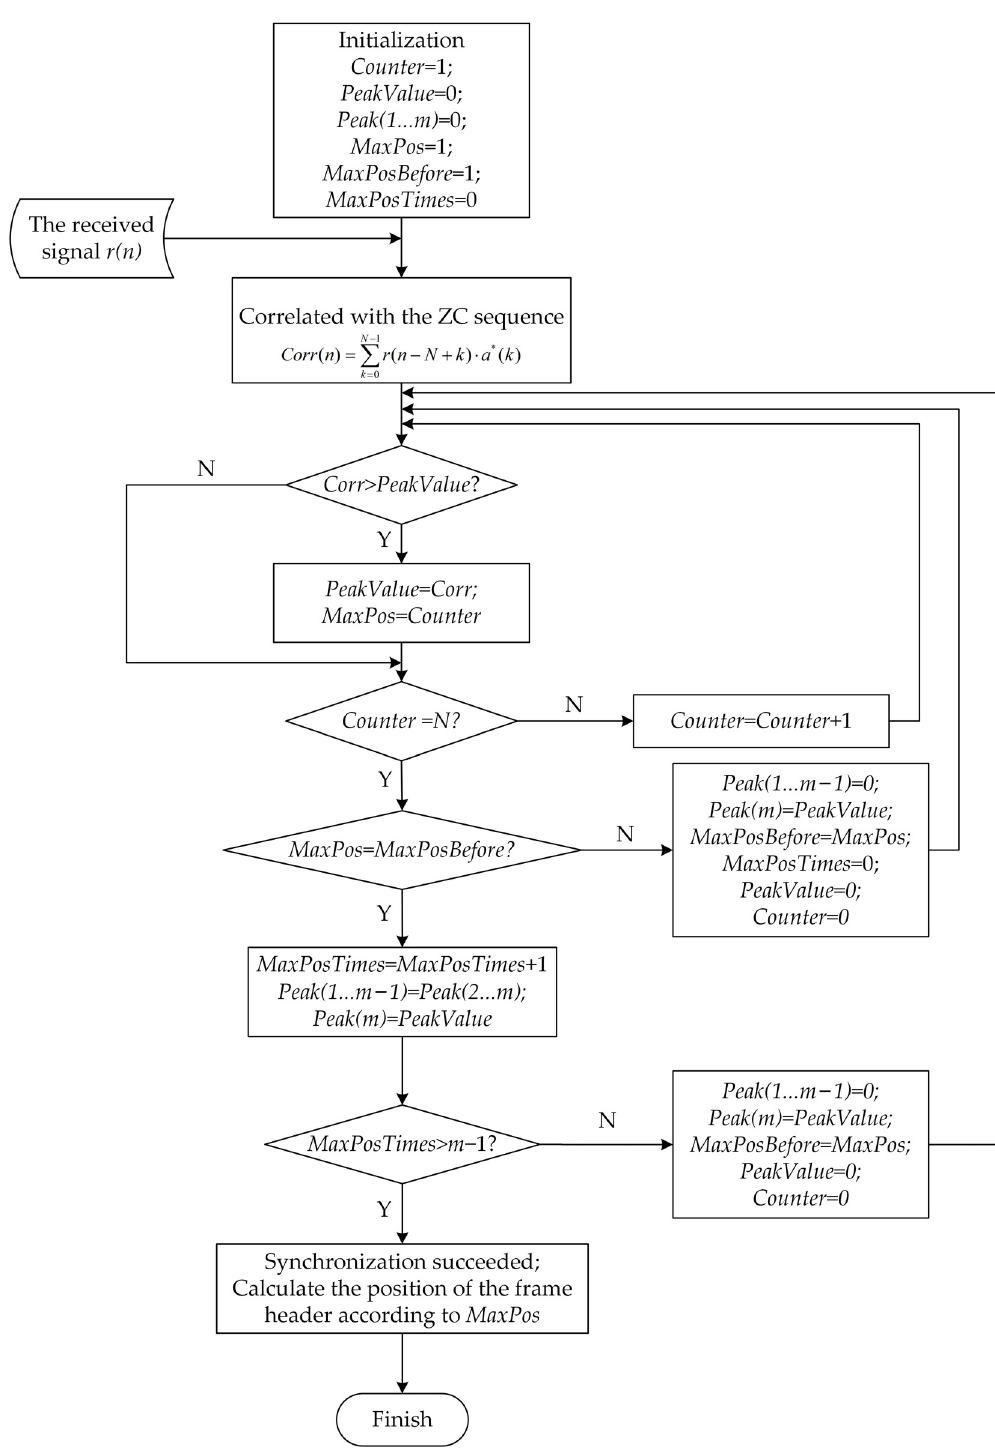
Figure 5. The fl owchart of the continuous correlation peak detection (CCPD) algorithm. Figure 5. The flowchart of the continuous correlation peak detection (CCPD)